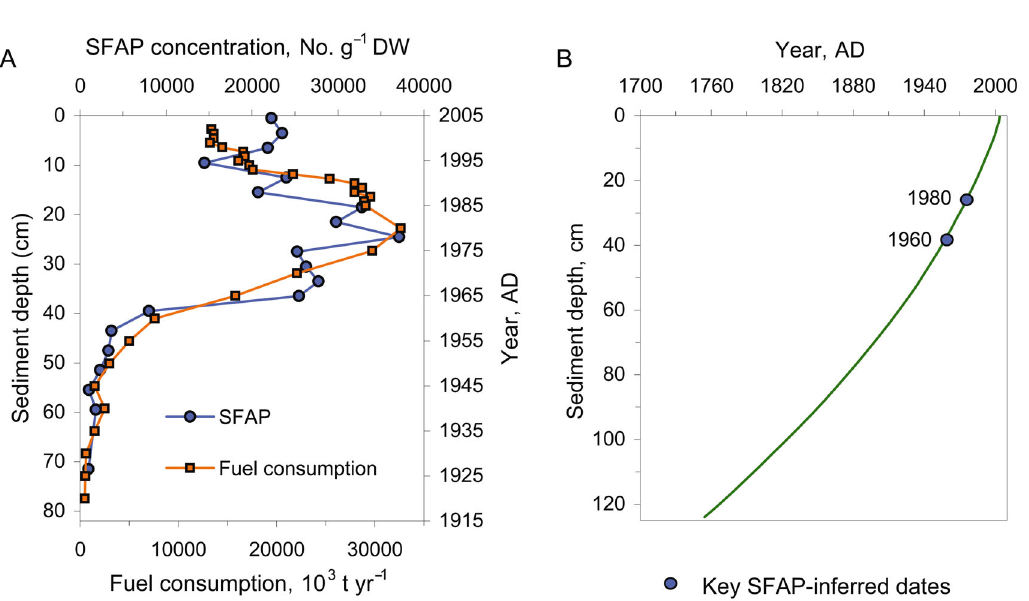
Fig. 3. Chronology of the Lake Kooraste Kıverj(cid:228)rv sediment core. A , the distribution profile of spheroidal fly-ash particles (SFAP) in sediment dry weight (DW) plotted against the data of fossil fuel consumption history in Estonia. B , the age-depth curve of sediments up to a depth of 125 cm, obtained by extrapolating the SFAP age-scale to deeper layers. Key SFAP-inferred dates are